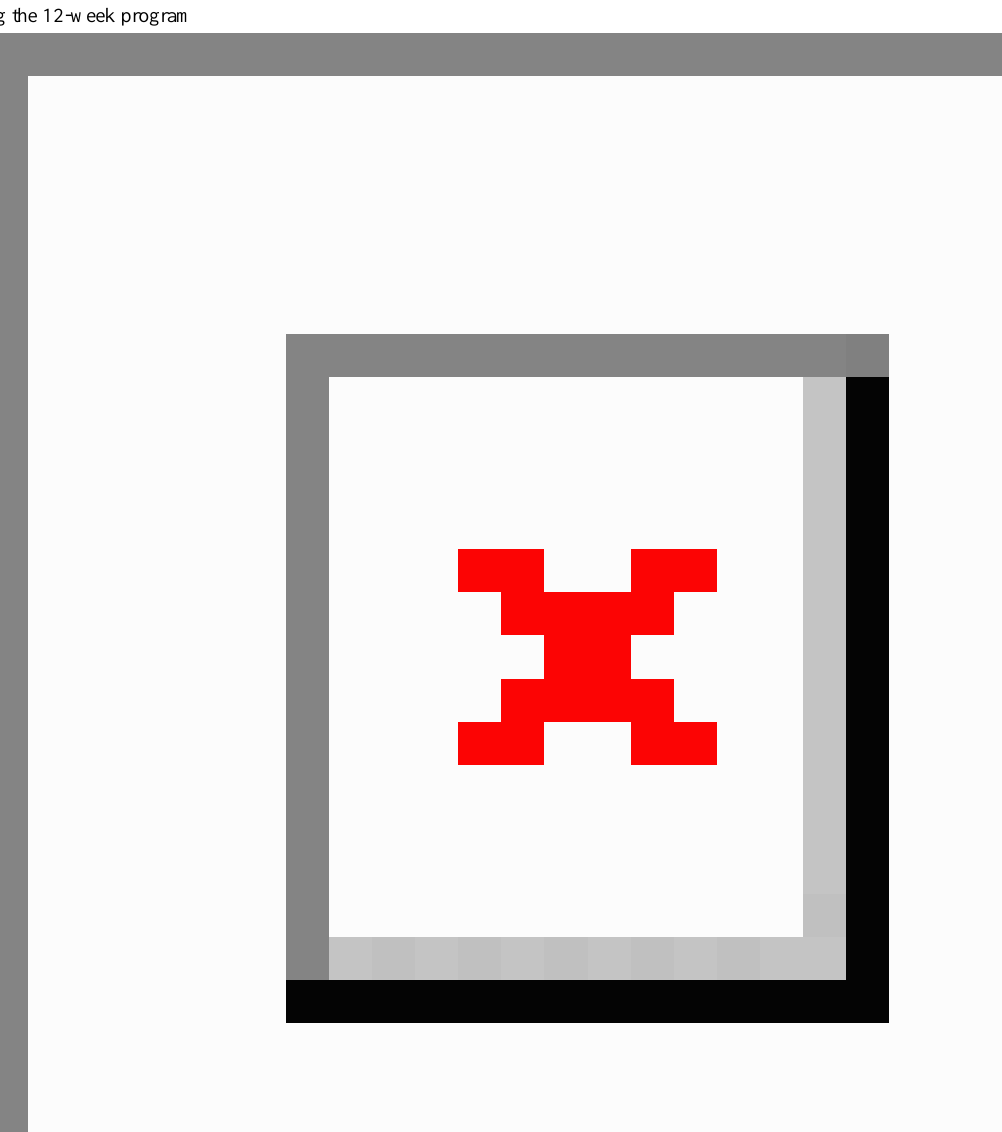
Figure 6. Weight change from baseline using the LOCF and the mode in which the most time was spent for each employee uploading weight data during the 12-week